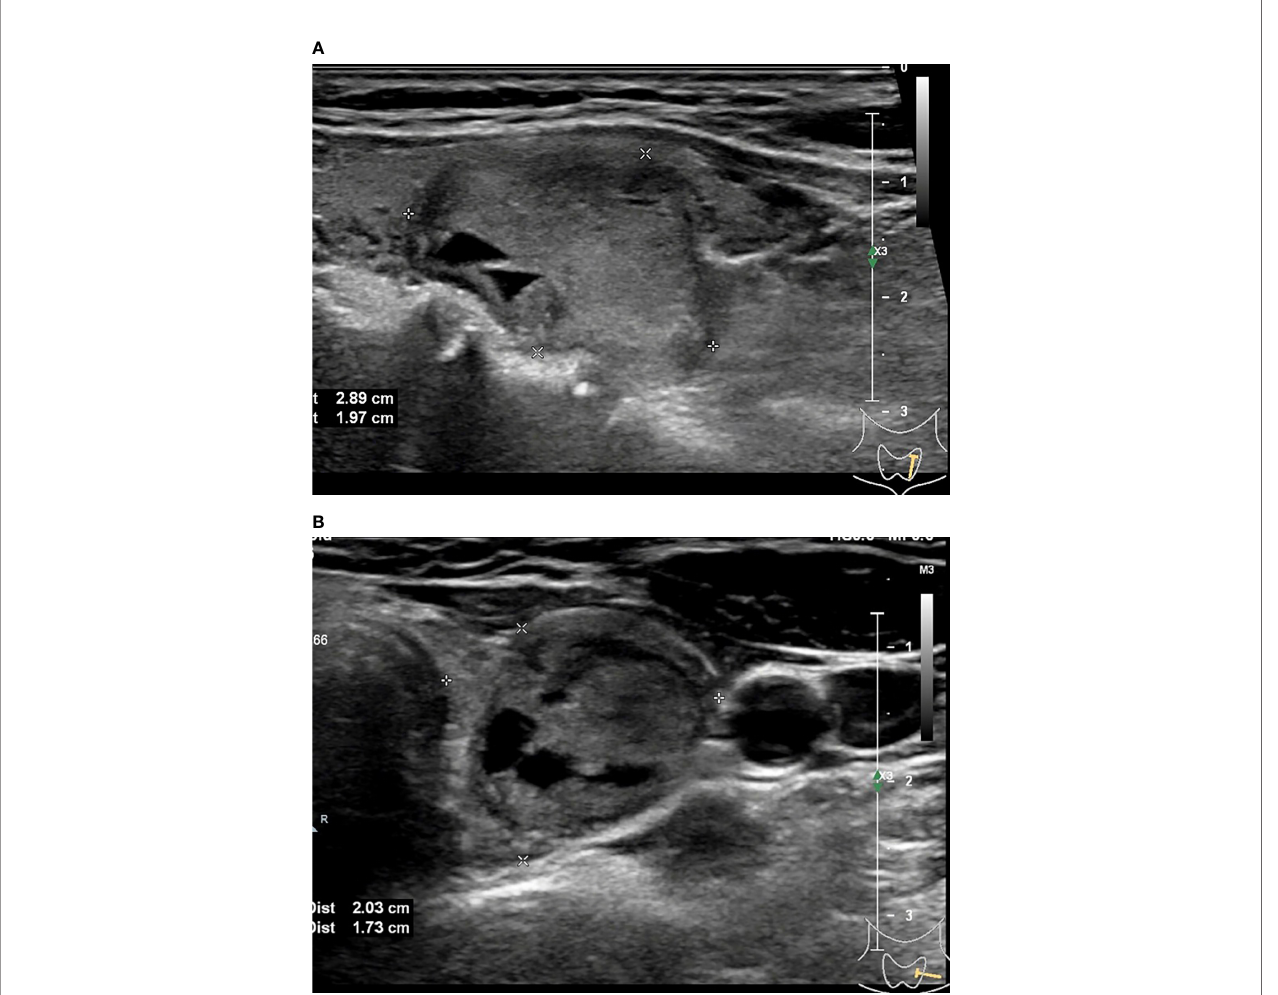
FIGURE 3 | 45-year-old woman with thyroid papillary carcinoma. Sonographies of longitudinal scanning (A) and axial scanning (B) show the nodule locates at the left lobe of the thyroid, characterized by 28.9mm×19.7mm×19mm in size, mixed solid-cystic composition, irregular shape, A<T orientation, hypoechoic and anechoic, discernible margin, and slight posterior acoustic enhancement. C-TIRADS 3, K-TIRADS 3, ACR-TIRADS 4. Histopathology con fi rmed it is a papillary